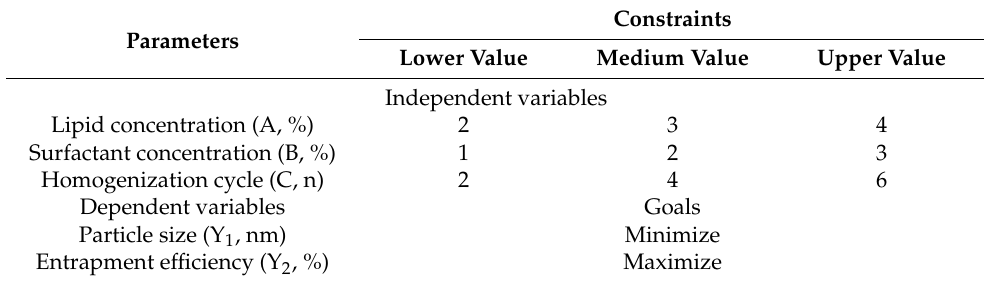
Table 1. Formulation variables range used to optimize BF-loaded